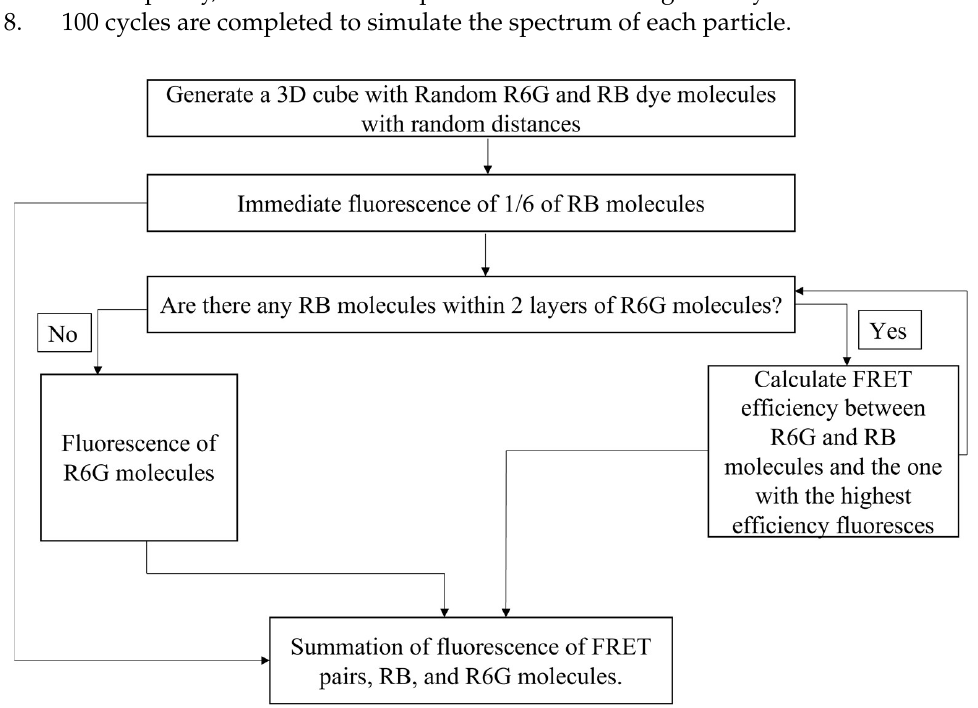
Figure 1. A flow chart of the steps involved in the simulation of fluorescence spectra of SiNPs encapsulated with two different dye molecules.